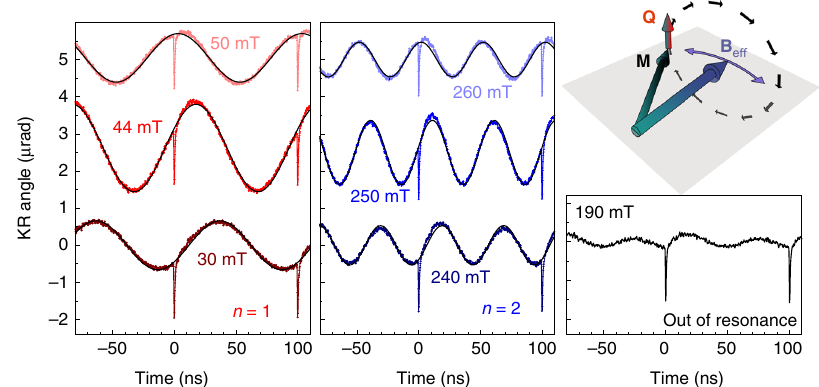
Fig. 2 Magnon signals in time domain. Transient Kerr rotation signals measured in the vicinity of the fi rst (left panel) and second (central panel) resonances and at the intermediate magnetic fi eld of 190 mT, corresponding to off-resonance (right panel). The ampli fi cation of the precession amplitude observed at B = B 1 = 44 mT and B = B 2 = 250mT is due to thermally induced resonant driving of the precession M by the oscillating effective fi eld B eff . The torque Q acting on the magnetization (see sketch at the top right) is maximal at the resonance conditions: f = nf 0 .